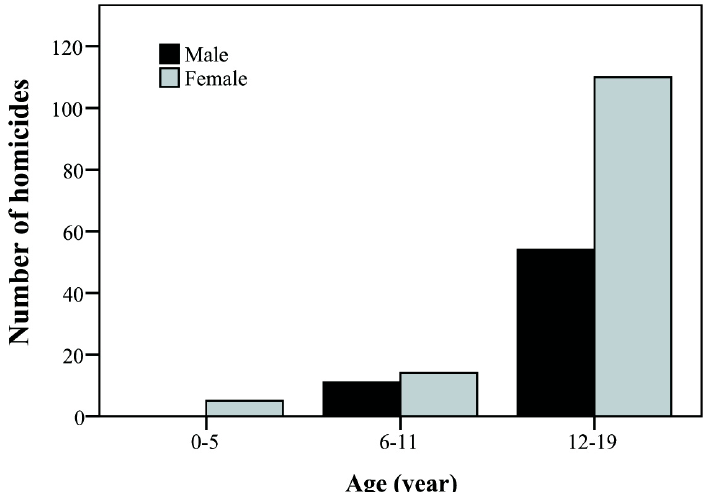
Figure 3. The temporal change of homicide between 2002 and 2009.